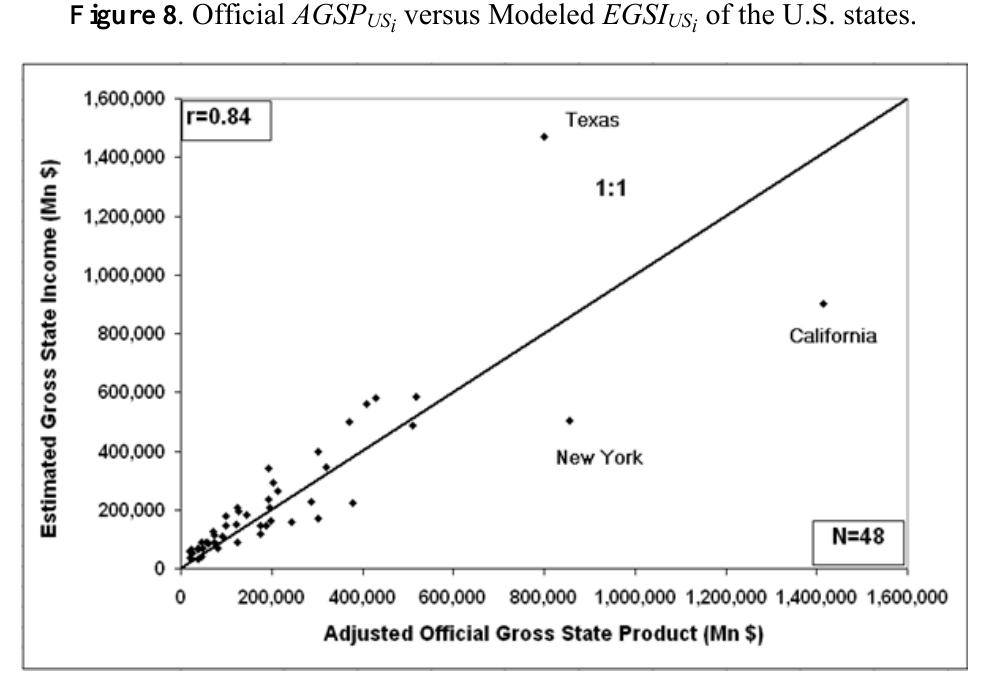
Figure 8 . Official AGSP